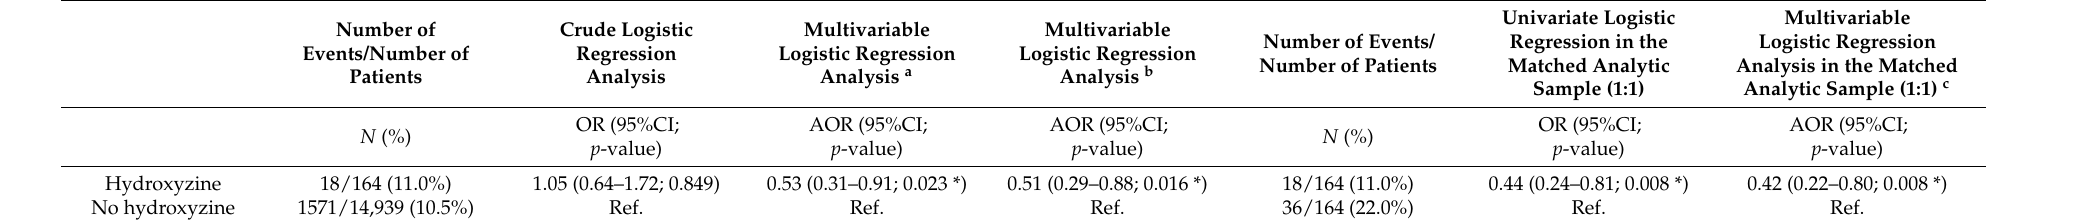
Table 2. Association between hydroxyzine use and mortality in the full sample and in the matched analytic